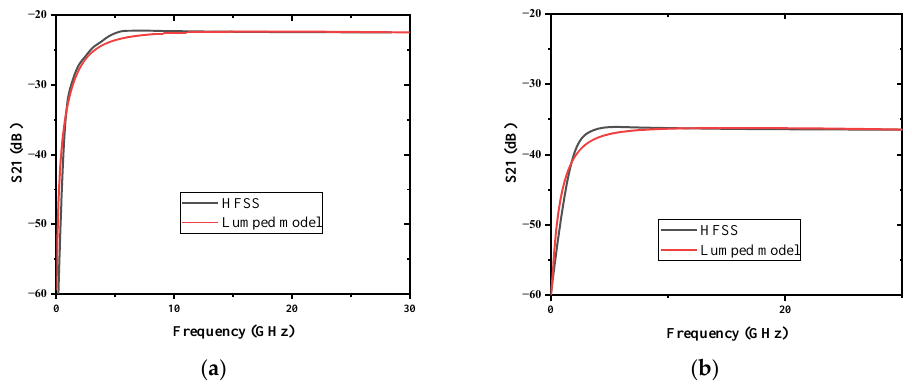
Figure 9. Comparison of S parameters between TDC and model with different ℎ 𝑡 : ( a ) ℎ 𝑡 = 0.024 mm; ( b ) ℎ 𝑡 = 0.08 mm.